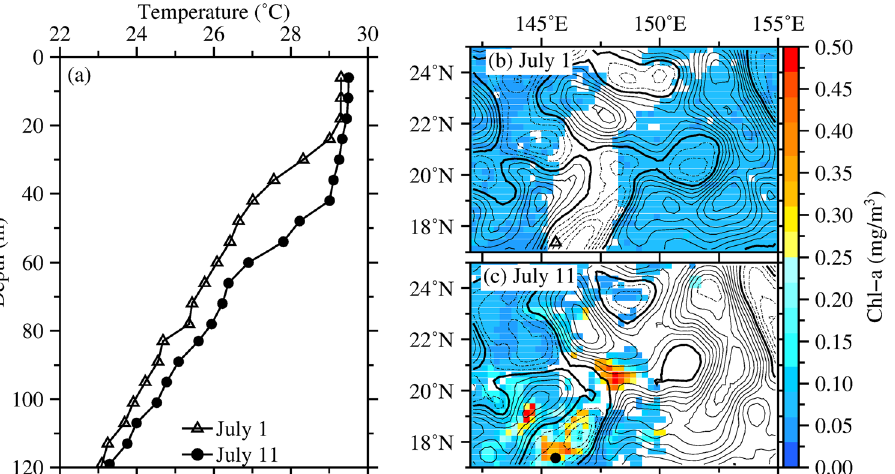
Figure 8. ( a) Temperature profiles of Argo Q5900121 measured on July 1 (triangle) and July 11 (circle). ( b ) SSHAs (contour interval: 4 cm, dashed: negative, solid: positive, bold solid: zero) overlaid on Chl (colors, units in mg/m 3 ) on ( b ) July 1 and ( c ) July 11, 2003. Triangle and circle symbols in ( b ) and ( c ) indicate the location of Argo Q5900121, respectively. This figure was generated using open source Generic Mapping Tools 33 (Ver. 5.3.0